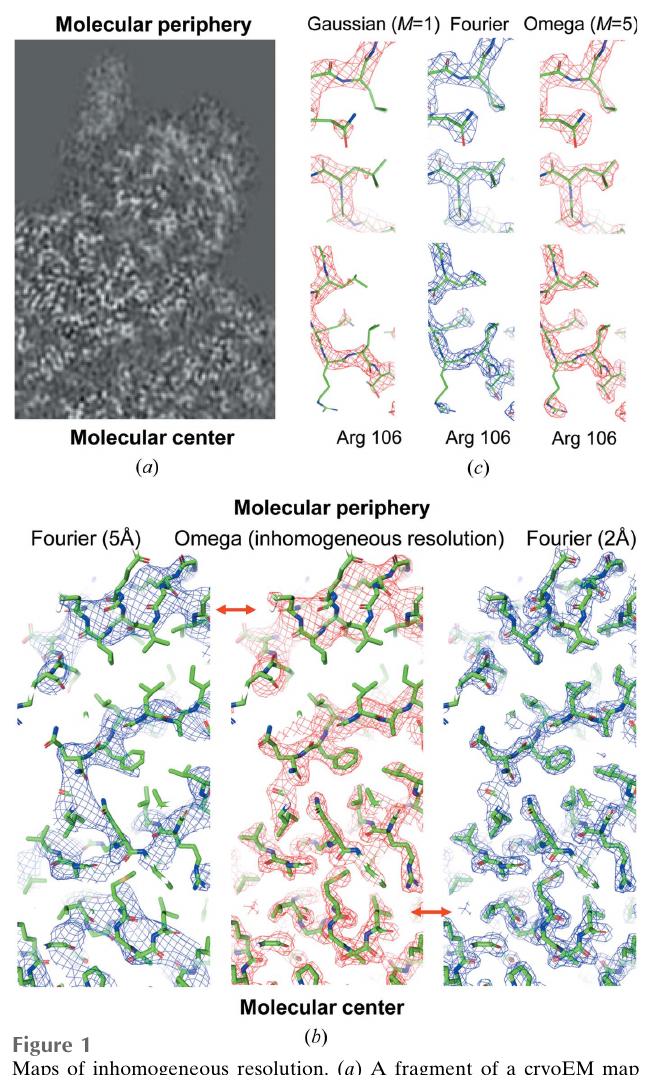
Figure 1 Maps of inhomogeneous resolution. ( a ) A fragment of a cryoEM map (von Loeffelholz et al. , 2018; EMDB 4261) illustrates a decrease of the local resolution from the molecular center to the periphery. ( b ) Test model (cid:2) -map (equation 15) of an inhomogeneous resolution varying from 2 A˚ in the molecular center to 5 A˚ at the molecular periphery calculated in a single run by the shell decomposition (middle), and the maps calculated by the Fourier procedure with the resolution of 5 A˚ (left) and 2 A˚ (right). Red arrows mark the similarity of different parts of the (cid:2) -map with the Fourier maps of different resolution. ( c ) Fragments of the 2 A˚ resolution maps contoured to show an equal volume (Urzhumtsev et al. , 2014). The map in the middle was calculated by the standard Fourier procedure. The left-hand map calculated as the sum of the Gaussian approximation, M = 1, to the atomic images (no ripples included) reveals the density for some side chains poorly. The right-hand map was calculated by the shell decomposition (equation 15) with M = 5 and reproduces the Fourier map correctly. Poor density for the Arg106 residue in the (cid:2) - and Fourier maps can be attributed to large displacement parameters of its atoms. This figure was prepared with PyMol (DeLano,